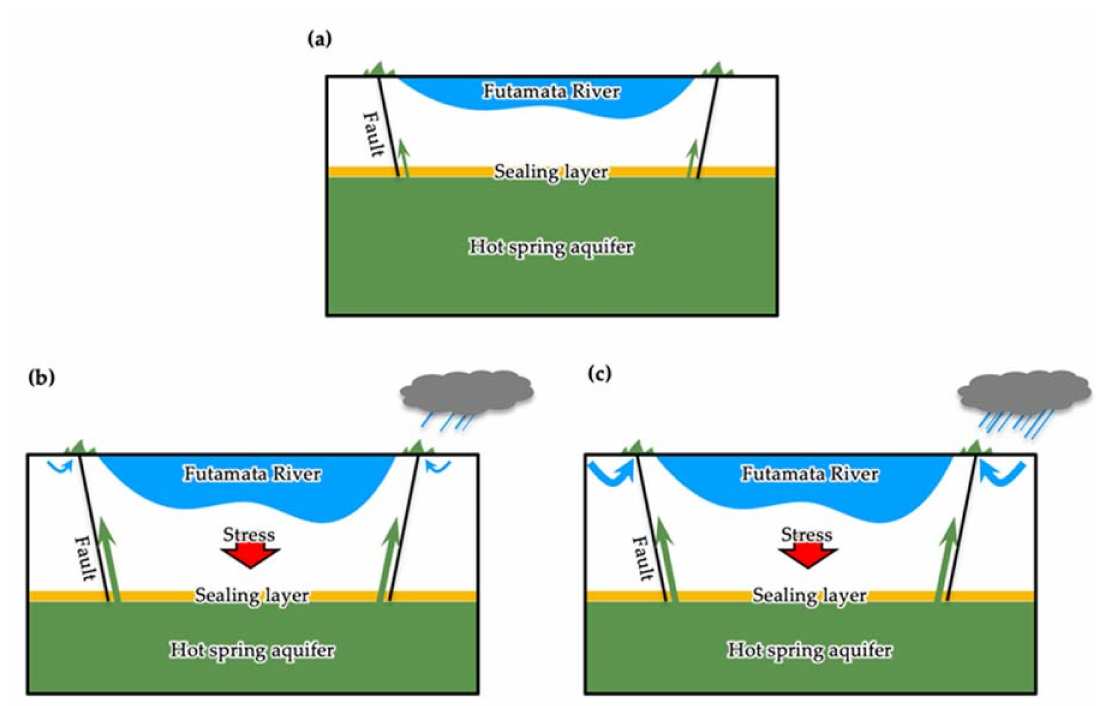
Figure 6. Discharge mechanism of the Futamata hot spring when precipitation occurs. ( a ) The Futamata hot spring discharges through highly permeable cracks such as faults; ( b ) when “events with small precipitation intensity” occur, the downward stress increases as the level of the Futamata River increases, and the stress in the hot spring aquifer also increases. Increased stress in the hot spring aquifer leads to an increase in pore pressure and the discharge water rate increases; ( c ) when “events with large precipitation intensity” occur, the hot spring water is diluted by a large amount of precipitation over a short